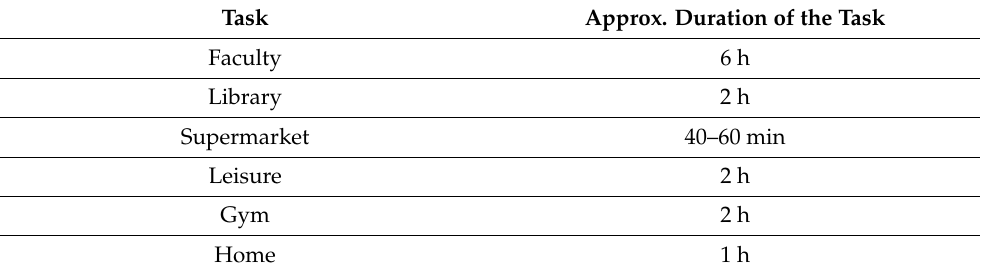
Table 3. Tasks undertaken by student agents during the day.